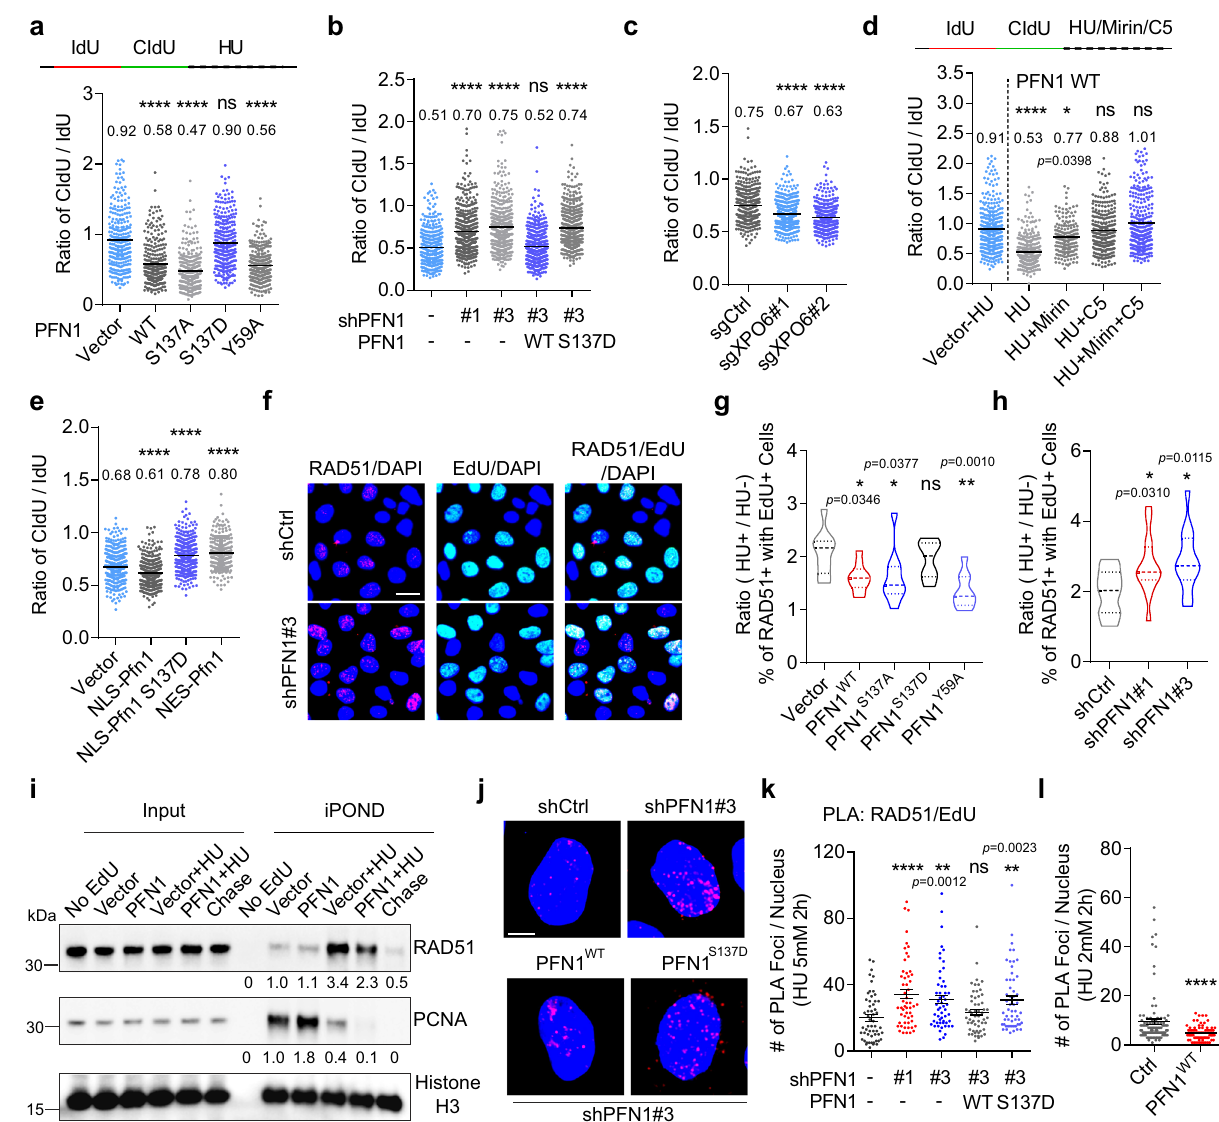
Fig.4|PFN1decreasesthestabilityofstressedDNAreplicationforks.a – c MCF- 10A cells with PFN1 overexpression ( a ), PFN1 knockdown/rescue ( b ), and XPO6 knockout( c )weresequentiallylabeledwith25 μ MIdUand250 μ